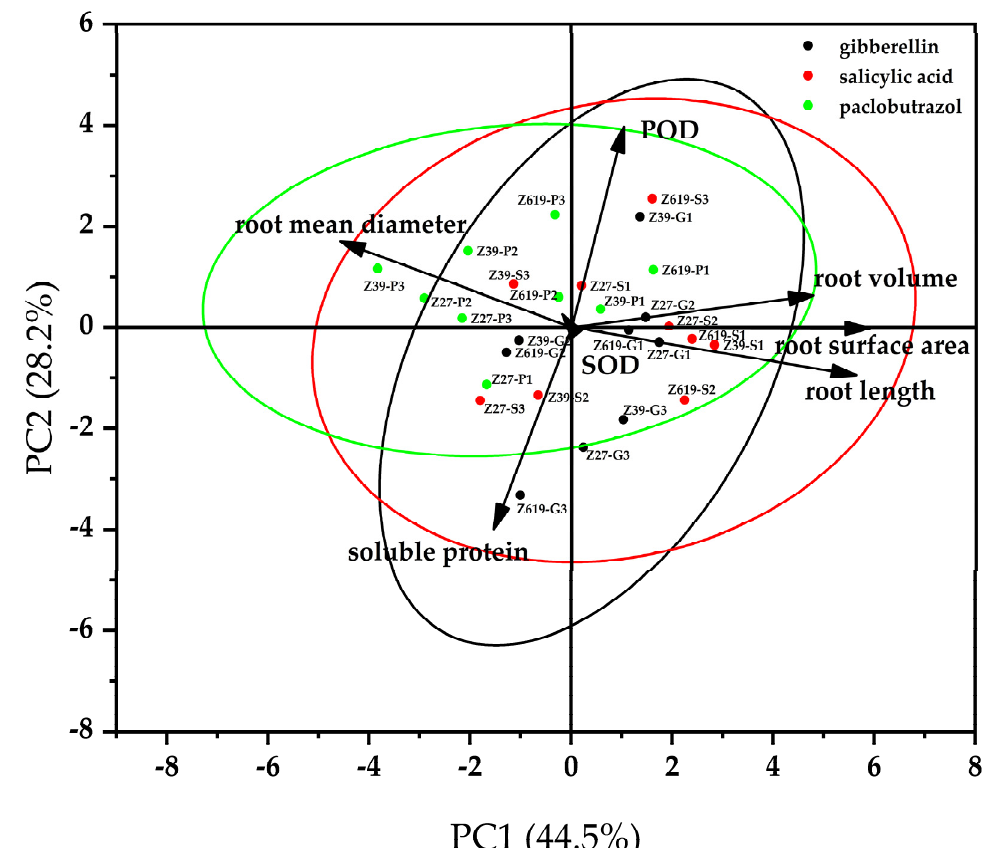
Figure 8. Principal component analysis diagram of cotton variety and growth regulator.